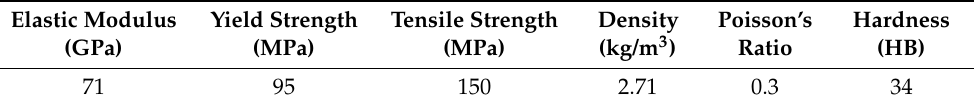
Table 1. Physical and mechanical properties of aluminum alloy A1050.